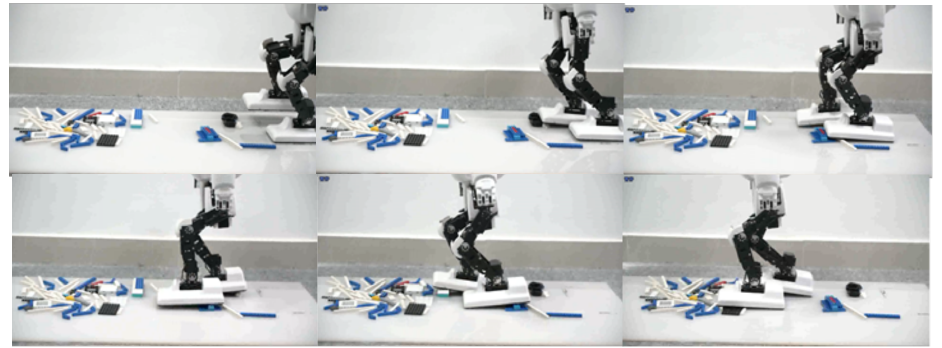
Figure 13. Walking on the floor covered with building blocks.